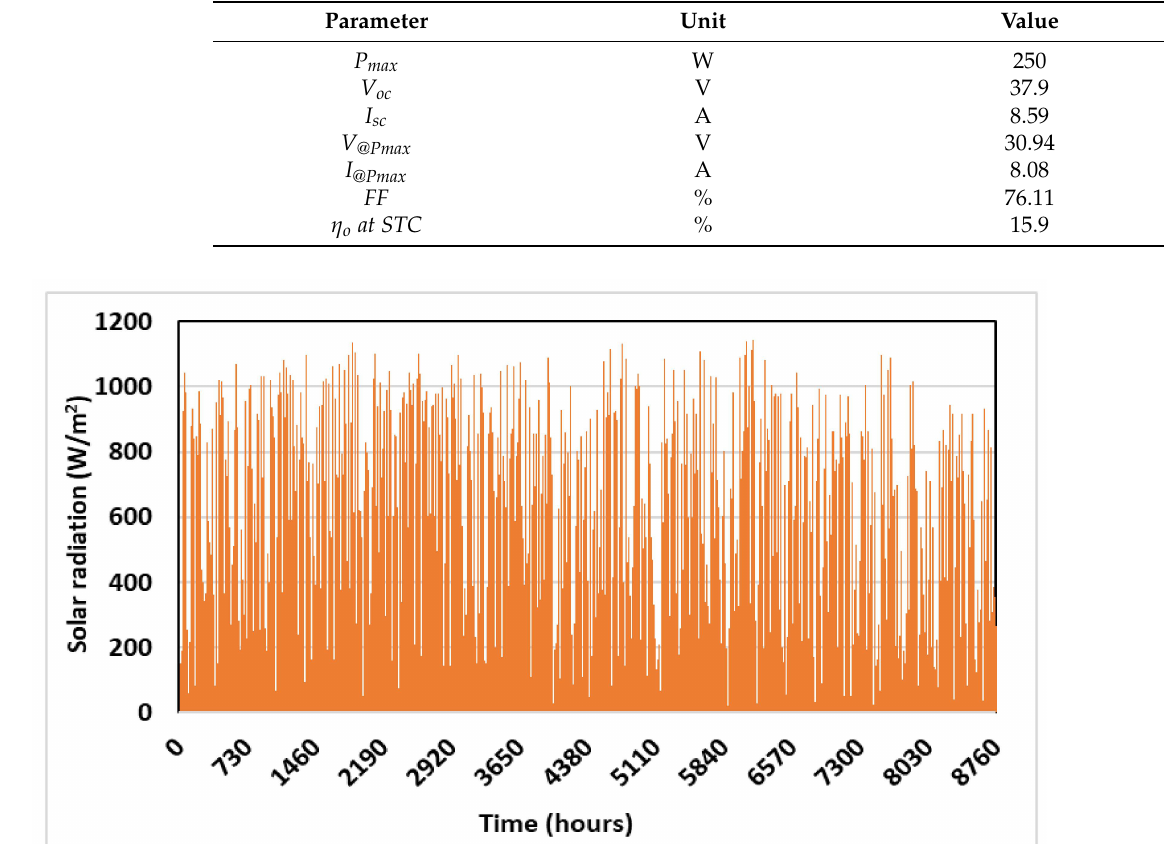
Figure 3. Solar radiation at the